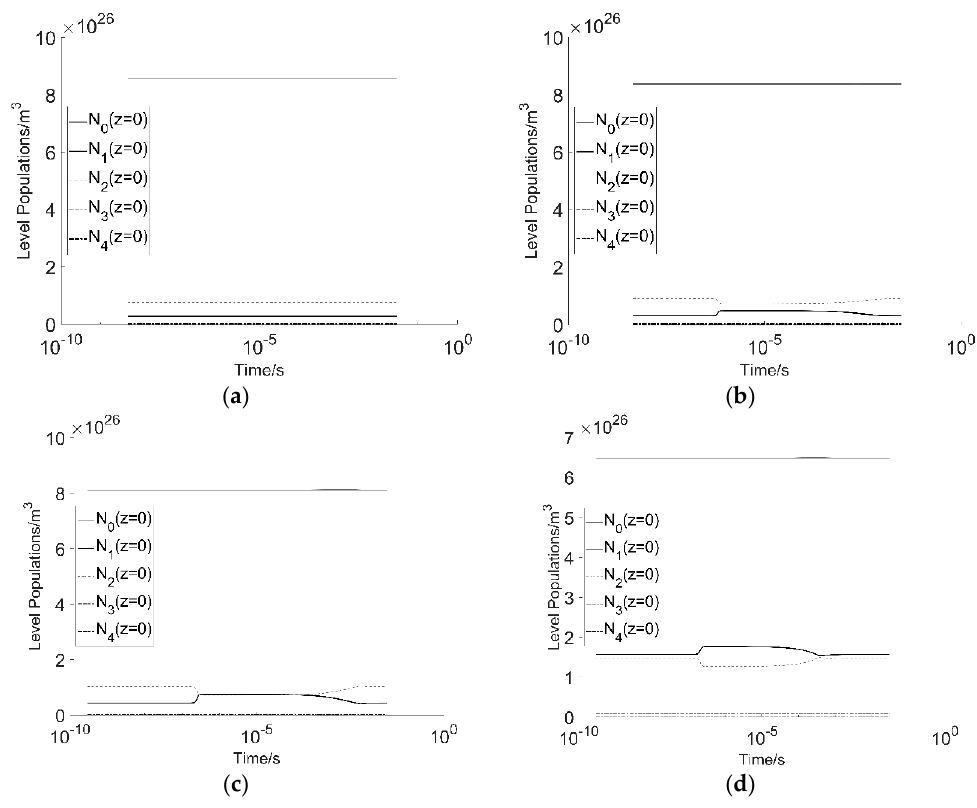
Figure 9. Numerically calculated dependence of the energy level populations on time for a 2 (m) long fiber with the facet reflectivity for signal wave at z = L switched between 0.04 and 0.2 and 0.2 and T tr = 200 (ns): ( a ) At pump power of 1.2 (W); ( b ) At pump power of 1.5 (W); ( c ) At pump power of 2 (W); ( d ) At pump power of 8 (W).